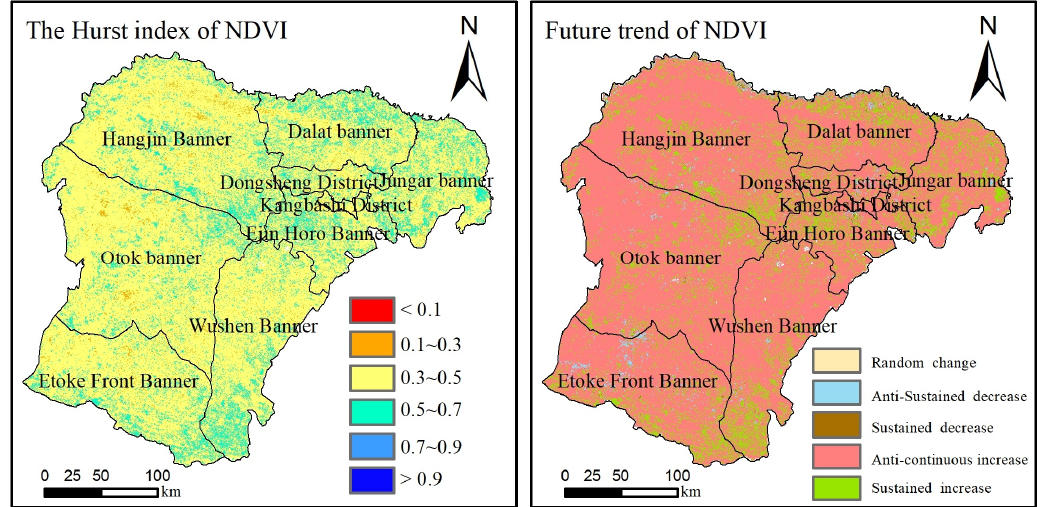
Figure 3. Spatial distribution and future evolution trend of vegetation NDVI Hurst index in Ordos City.